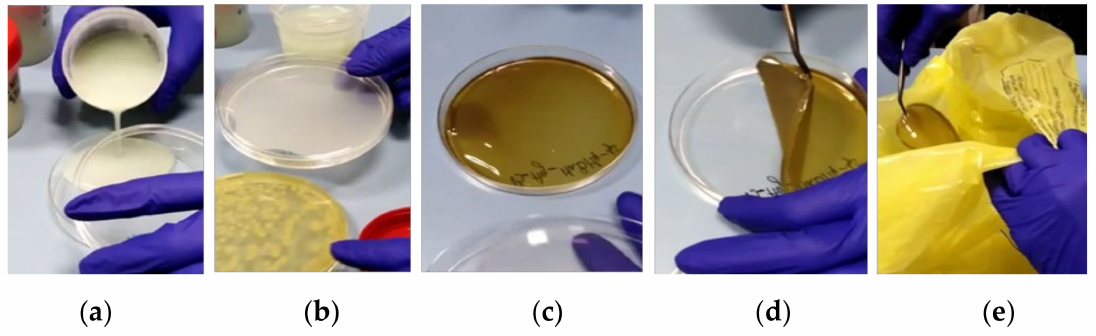
Figure 6. Decontamination using eco-friendly active nanocomposite peelable coatings: ( a ) decontamination solution, ( b ) decontamination solution is allowed to neutralize the contaminant, ( c ) dried peelable film, ( d ) peeling process and ( e ) decontamination